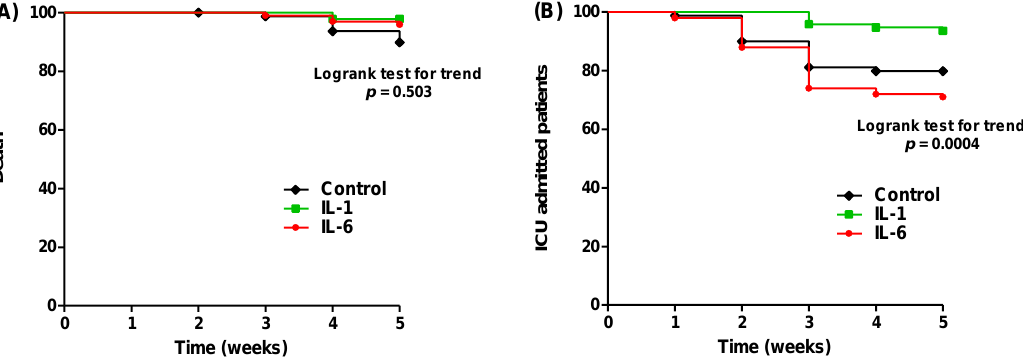
Figure 5. Kaplan–Meier plotting of ( A ) the death among patients after treatment with regimens including IL-1, IL-6 antagonists or not, ( B ) patients that were transferred to intensive care unit (ICU). A chi-square test followed by a Bonferroni post-hoc test was used to compare the difference in the proportion of numbers of deaths and ICU-admitted patients among the three tested groups. The chi-square test revealed a significant association between treatment regimens and ICU-admitted patients ( 𝜒 2 = 8.075, p < 0.05). Post-hoc analyses using pairwise comparisons showed that the proportion of ICU-admitted patients in the group treated with anakinra was significantly lower than in the group treated with the usual regimen ( 𝜒 2 = 7.019, p < 0.01) and in tocilizumab treated patients ( 𝜒 2 = 5.714, p < 0.05). (1) (1) These findings indicate the beneficial effect of anakinra on the COVID-19 mild to moder- ate cases when administrated in the early stages after infection. On the other hand, there was no significant difference in the proportion of deaths recorded in the three treatment regimens ( 𝜒 2 = 4.23, p = 0.12). (2)